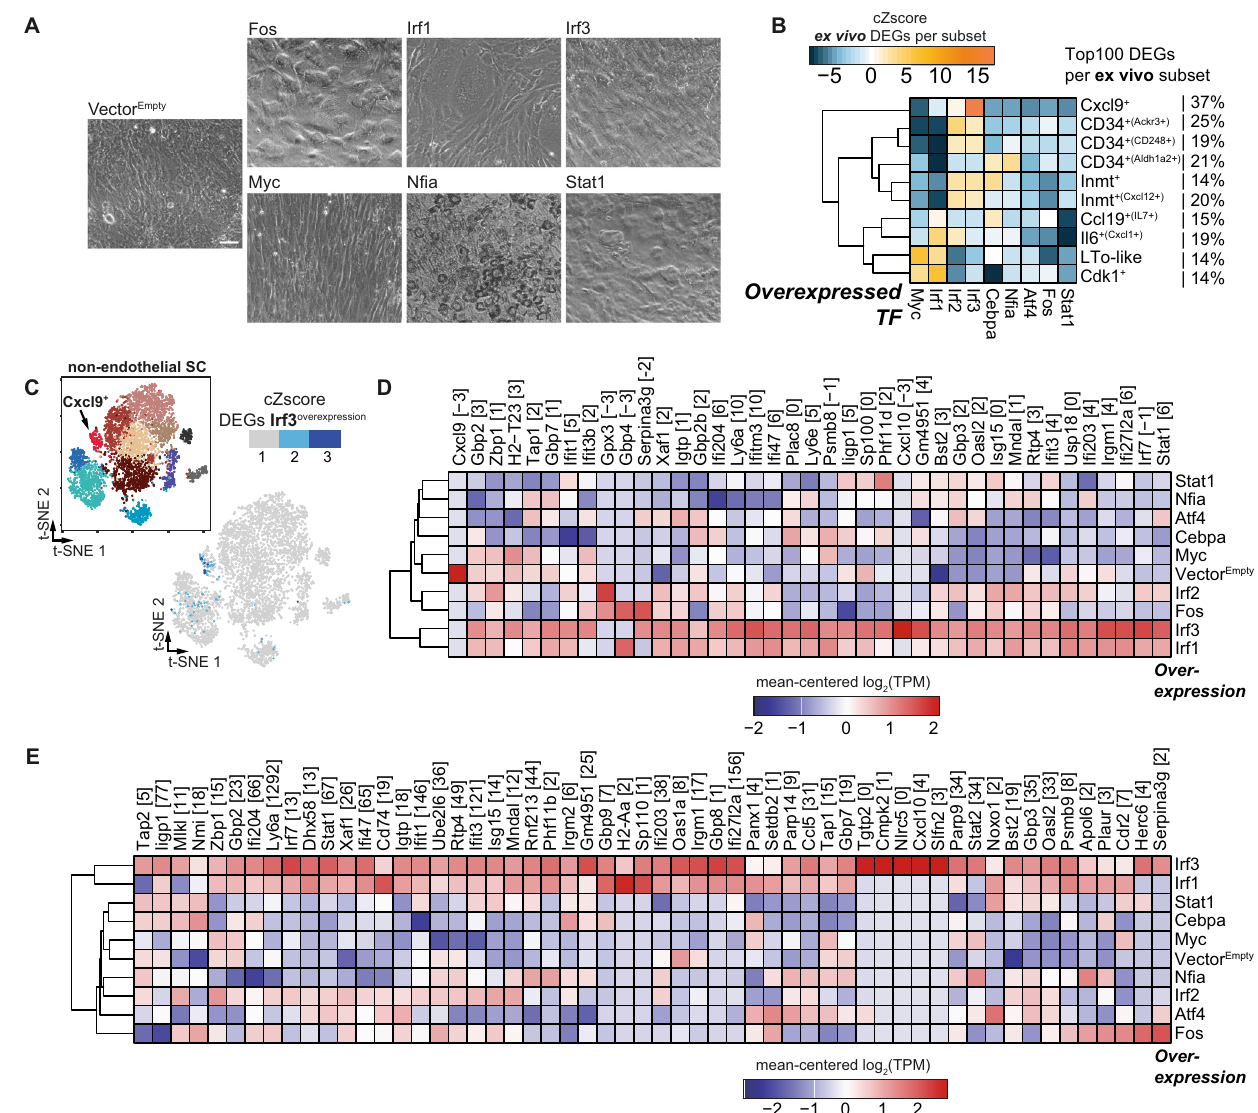
Fig. 6 | Irf3 promotes the differentiation of mesenchymal stem cells towards a Cxcl9 + FRCmolecularphenotype. MurineC3H10T1/2werelentivirallytransduced and puromycin-selected for stable vector integration. TF expression was doxycycline-induced and maintained for 12 days. Subsequently, BRB-seq was per- formed on the induced cells (3-4 replicates per condition from two independent experiments). A Representative phase contrast images of morphological pheno- types subsequent to overexpression-driven differentiation (scale bar = 30 µ m). B The heatmap depicts the cumulative Z-score (cZscore) of DEGs, compared to Vector Empty , at “ TF overexpression ” in the C3H10T1/2 cell line among the Top 100 DEGs per LN subset (Supplementary Data 2). The percentage indicates the